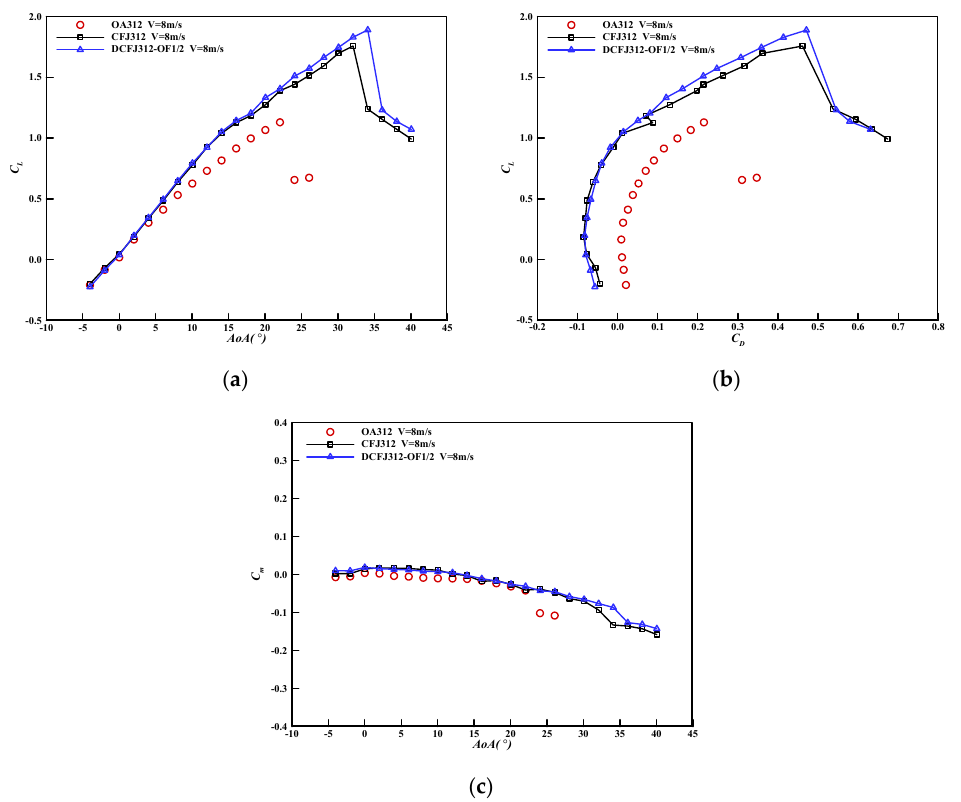
Figure 10. Aerodynamic coefficients comparisons of DCFJ312 and CFJ312 airfoils. ( a ) Lift coefficient; ( b ) lift-to-drag ratio; ( c ) moment coefficient.